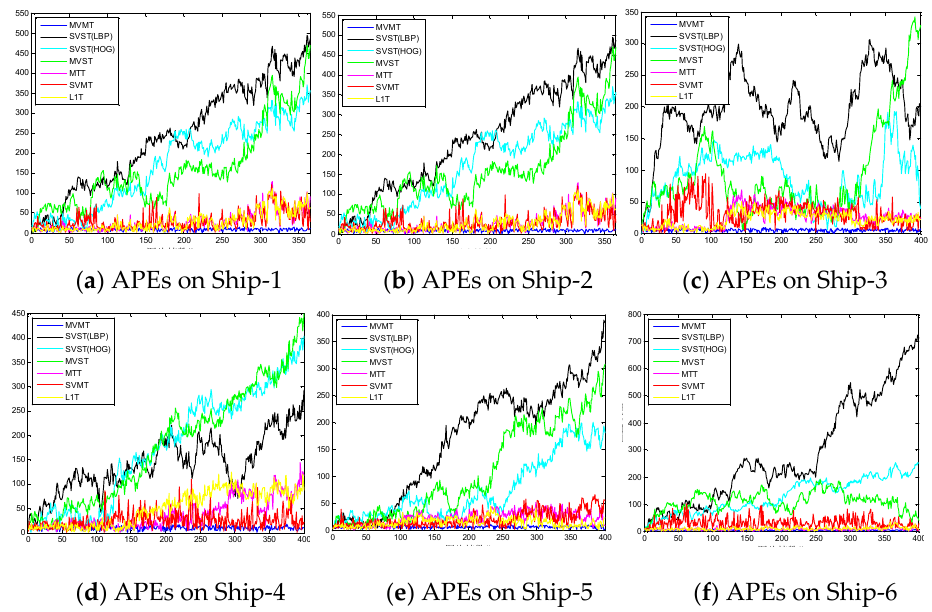
Figure 15. 7 Average position error (pixel) of 5 comparison methods. Table 1. Average error between results of five comparison methods and real position (pixels). Sequence Ship-1 Ship-2